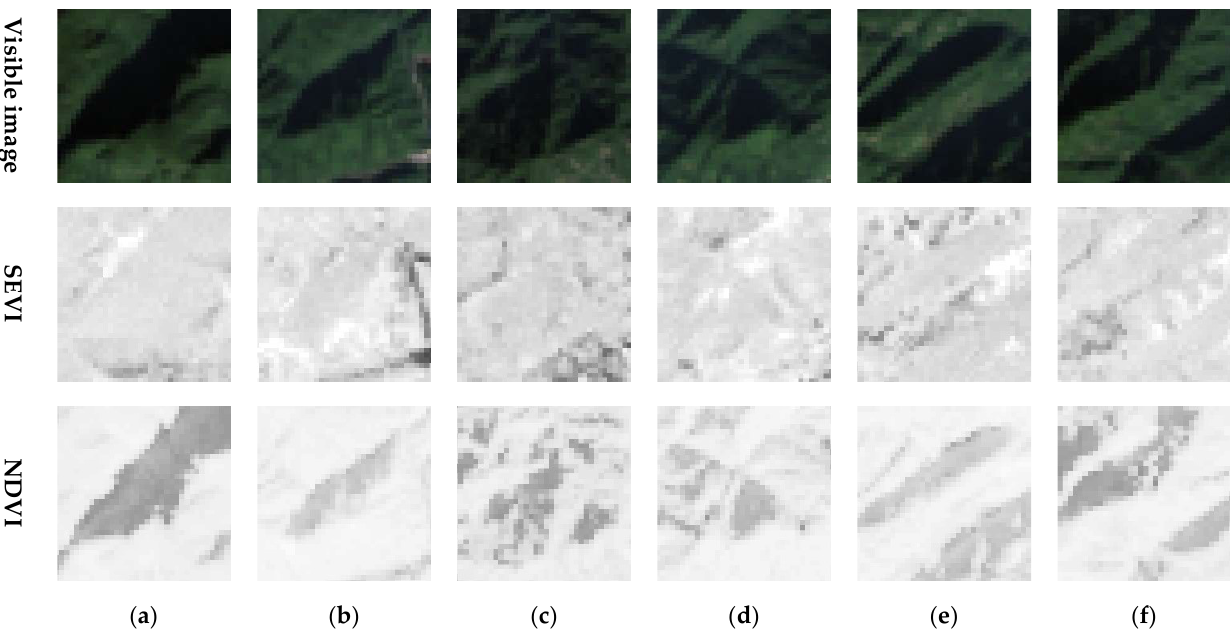
Figure 5. Visible image (RGB composite), shadow-eliminated vegetation index (SEVI), and normal- ized difference vegetation index (NDVI) of sample areas: ( a – f ) Six sample areas.